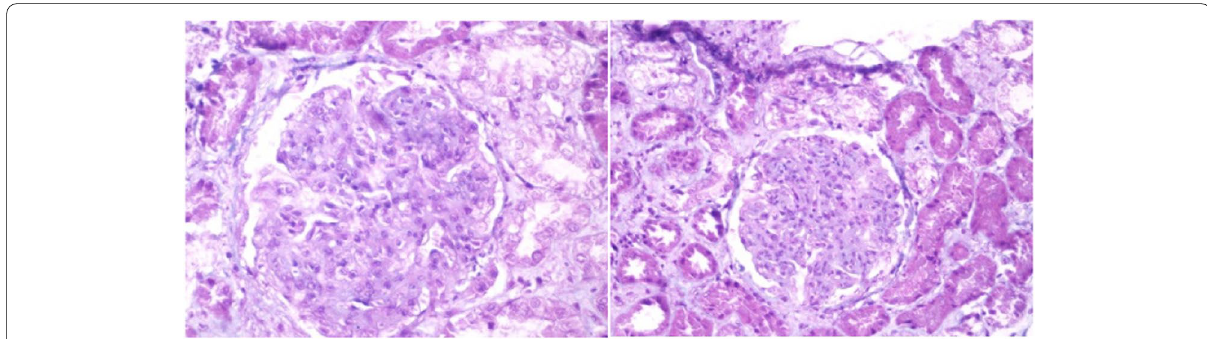
Fig. 3 Membranoproliferative glomerulonephritis with mesangial and endo-capillary